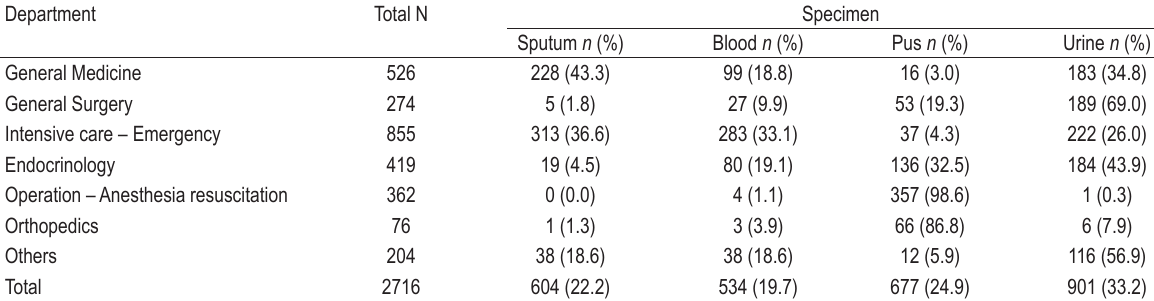
TABLE 2. Characteristics of the specimens